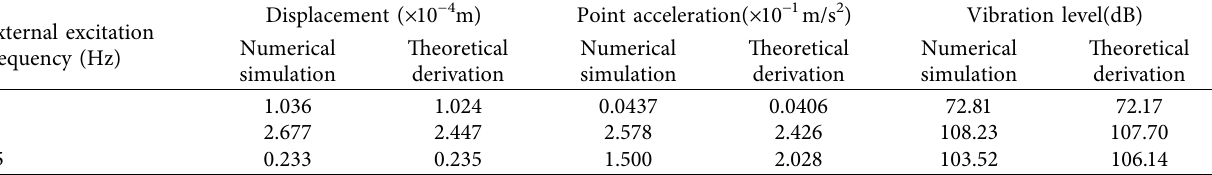
Table 1: Comparison of simulation results and theoretical derivation of points under different frequency excitations.